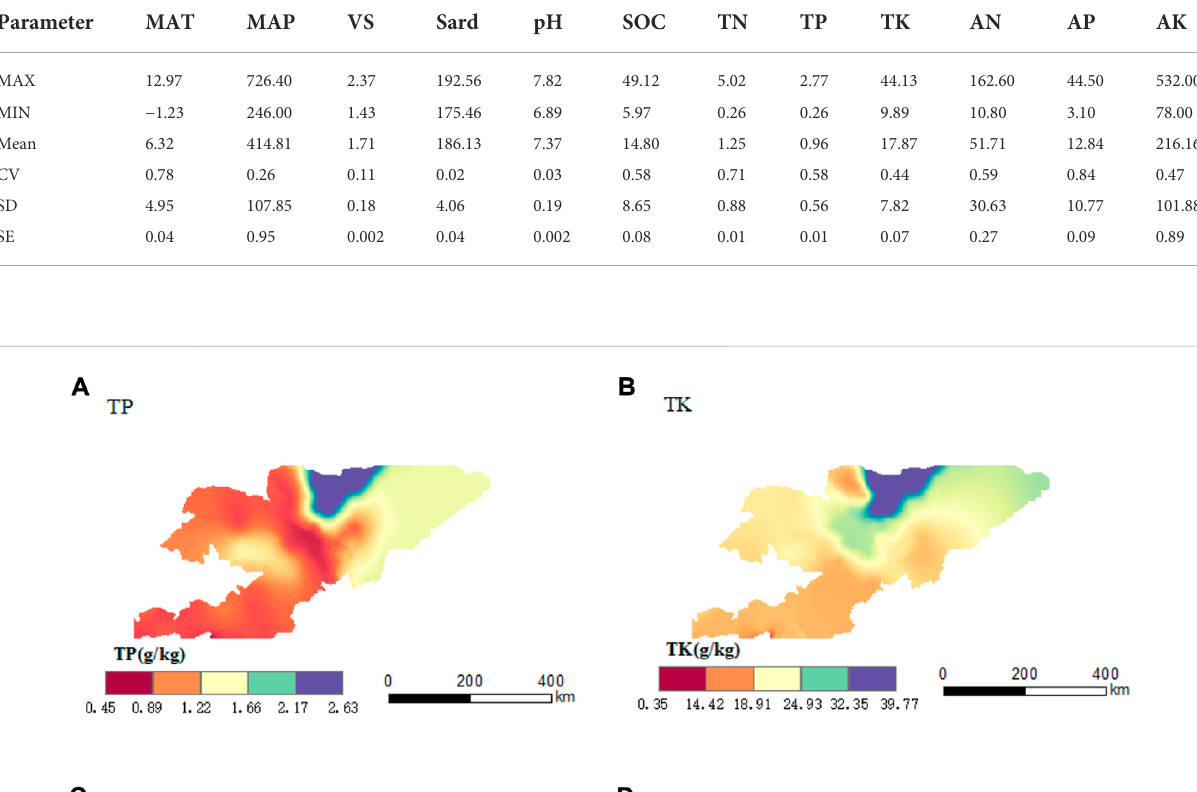
FIGURE 3 Spatial patterns of soil nutrient contents in the surface layer of soil (0 – 30 cm). (A – D) are the relative spatial distribution features of TP, TK, TN, and